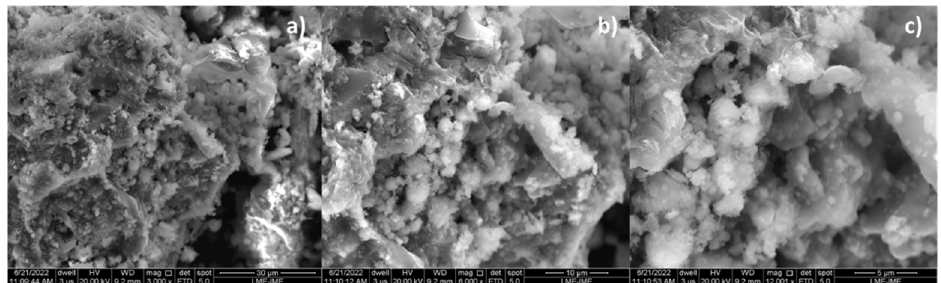
Figure 8. SEM of bio-char obtained by thermal catalytic cracking of (organic matter + paper) fraction of MHSW at 475 °C, 1.0 atmosphere, with 15.0% (wt.) Ca(OH) 2 [MAG: 3000× ( a ); MAG: 6000× ( b ); MAG: 12,000× ( c )].